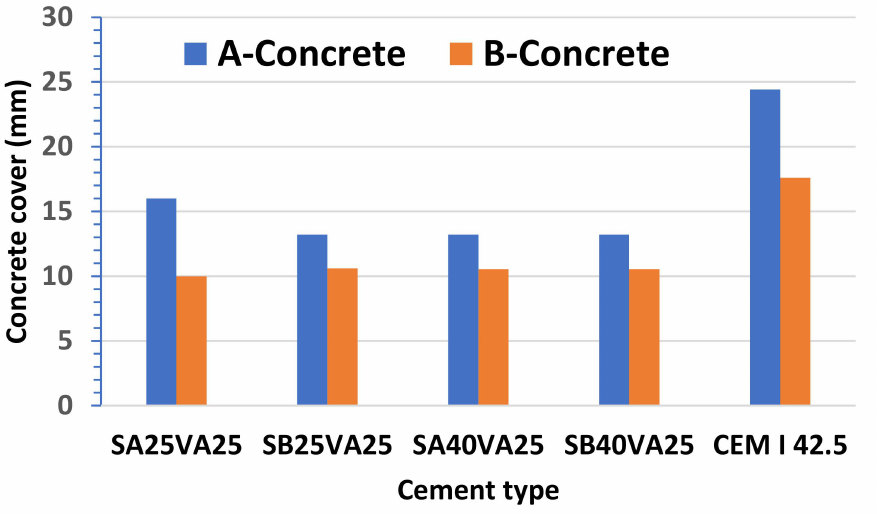
Figure 9. Minimum cover to ensure 50 years of service life of reinforced concrete structures by using concretes made with ternary cements (X, mm).